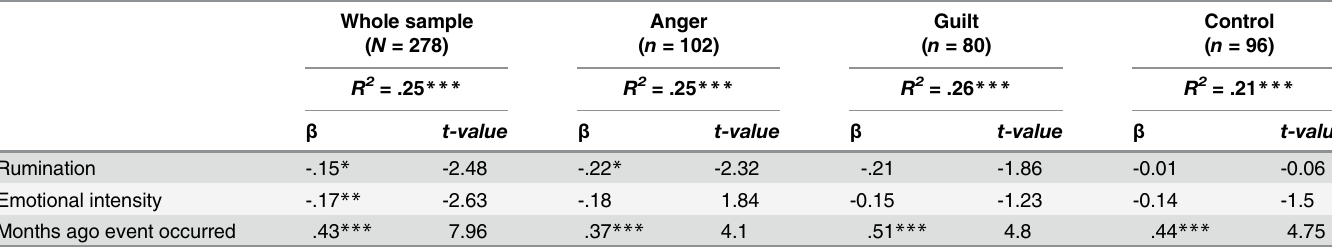
Table 3. Regression analyses from Study 2 predicting temporal psychological